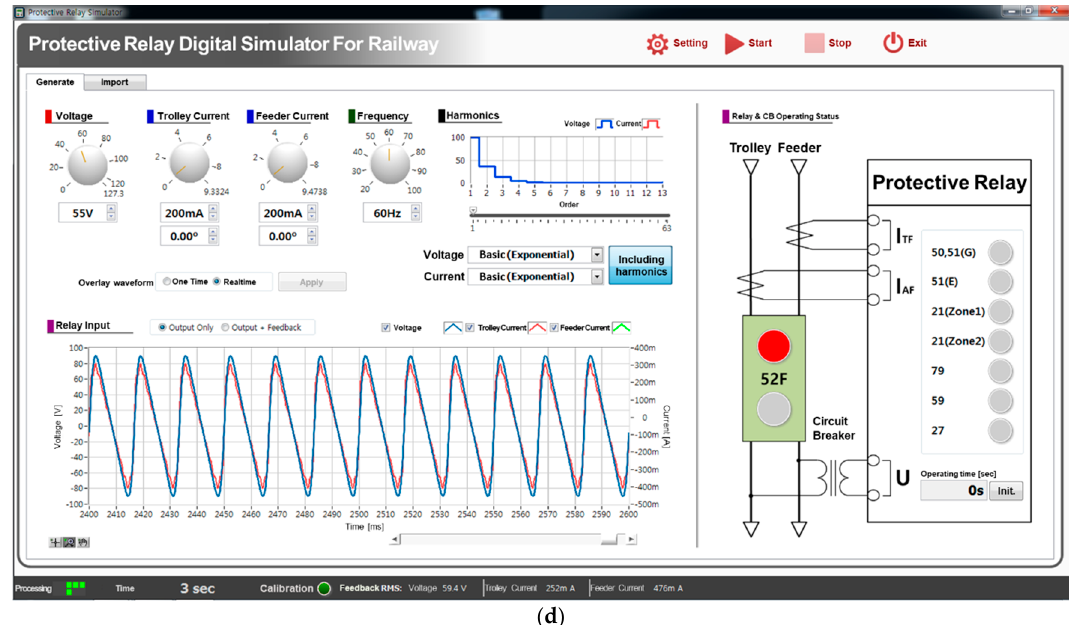
Figure 20. Simulation results for Case 5: ( a ) Input current; ( b ) Input voltage; ( c ) Protective relay signal; and ( d ) Digital simulator interface results.